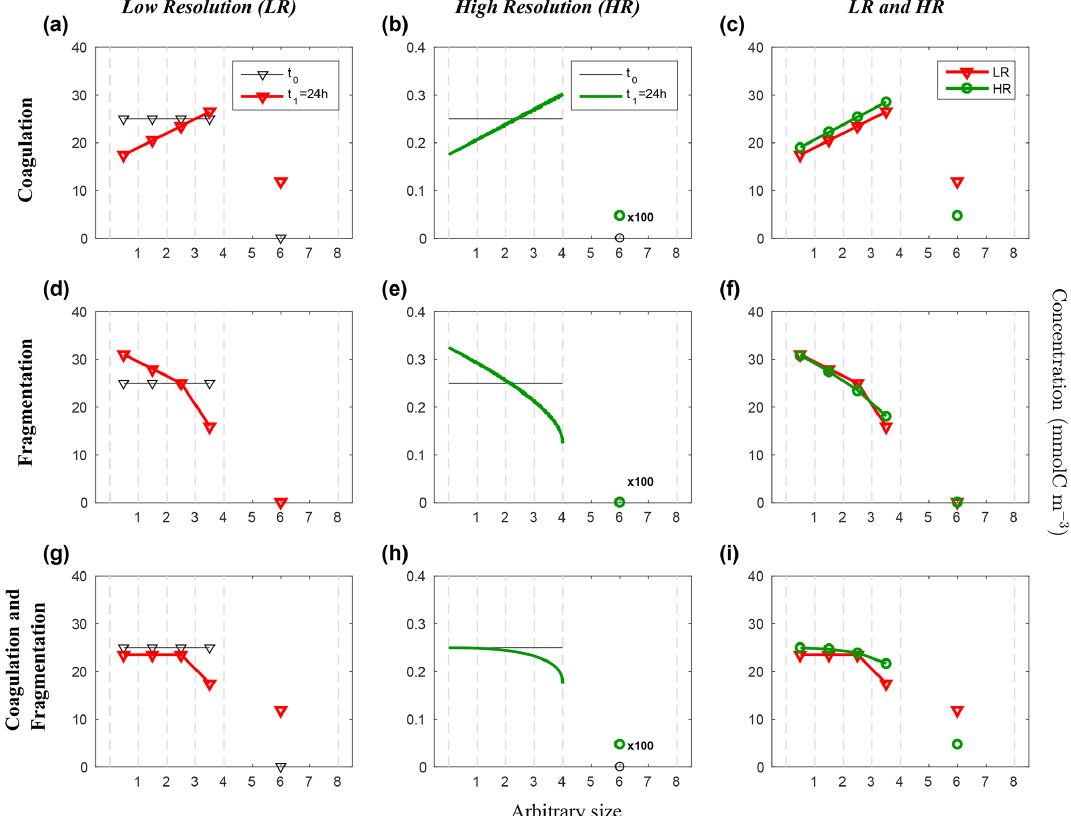
Figure 5. Evolution of the carbon concentration distribution over the size range in the linear size discretization configuration (E1) as function of the arbitrary size. Our three sets of reaction simulations are represented: coagulation only ( a–c ), fragmentation only ( d–f ) and when both reactions are combined ( g–i ). The left column (a,d,g) represents our LR setup, the middle column (b,e,h) the HR one and the right column (c,f,i) the comparison of the HR carried back to LR (see Eq. 25 in Sect. 3.1 for details). Y abscissas are different between our resolutions and are set to allow an easy comparison. For each panel, the initial time step t 0 is in black and the final time step t 1 = 24h appears in red for LR and in green for HR. As it is the linear size discretization configuration, the LR resolved bins indexes equal the arbitrary size. N for both resolutions, as they represent the average of a larger number of size bins (LR: 5 to 8, and Solitary points represent the size bin 3 2 HR: 401 to 800) than the ones in the resolved range. Notice that the final carbon concentration in the unresolved bin of the HR experiment is divided by a factor of 100 in order to fit in the y scale. As detailed in the methods (Sect. 2.3), both coagulation and fragmentation reactions occur in the resolved range but only fragmentation occurs in the unresolved range. For further details, refer to the legend of Fig.